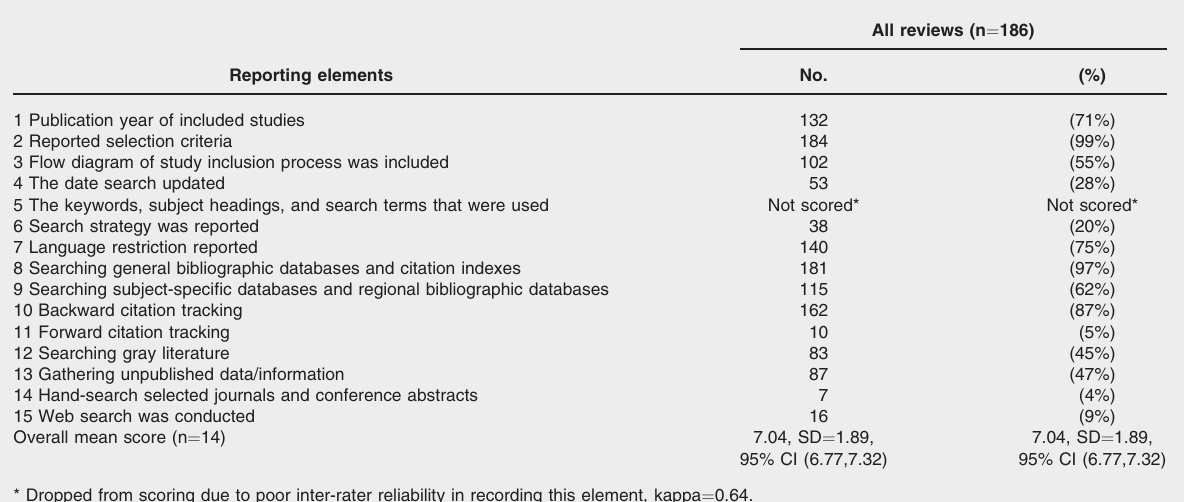
Reporting scores of methodological elements in all systematic reviews